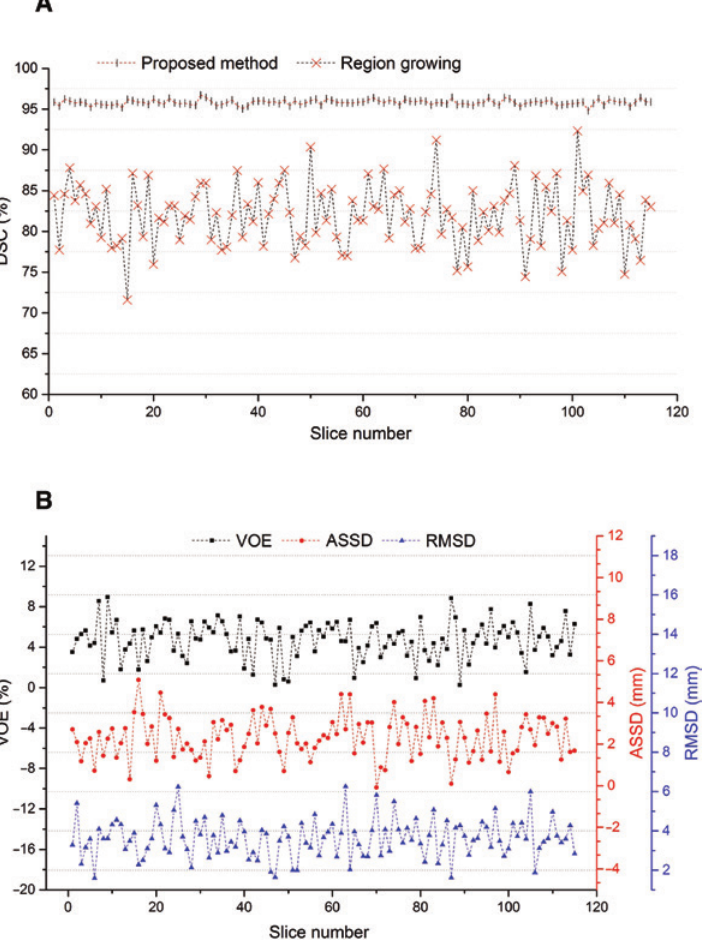
Figure 14: Comparison of Performance Evaluation Results.